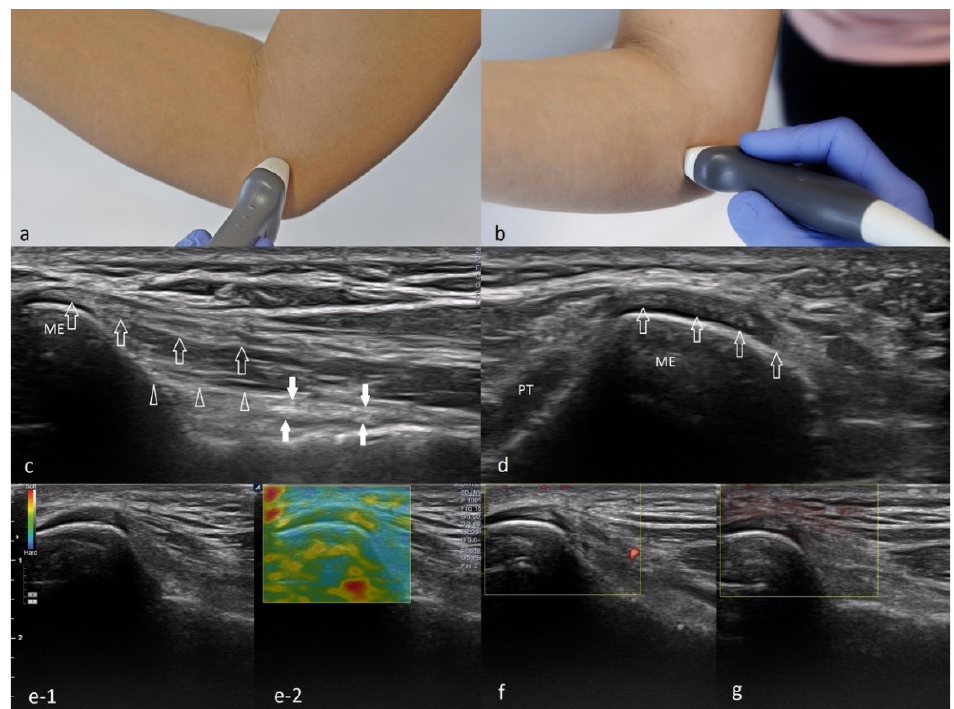
Figure 3. Ultrasound examination of common flexor attachment. Images ( a , b )—a method of applying the probe to obtain both ( a )—longitudinal, ( b )—transverse sections, ( c )—long axis view of a common flexor attachment (precisely above the attachment of the part corresponding to the flexor carpi radialis—FCR); open arrows—superficial, more tendinous portion of the FCR; open arrowheads—deep part of the FCR, with preserved muscular echo structure; white arrows—partially visible anterior part of the medial collateral ligament; ME—medial epicondyle. ( d )—Short axis view of the common flexor attachment—open arrows; ME—medial epicondyle; PT—proximal part of the pronator teres muscle (the humeral head). ( e )—Scans from strain elastography, ( f )—normal CFT in power Doppler mode, ( g )—normal CFT assessed with MicroFlow option.